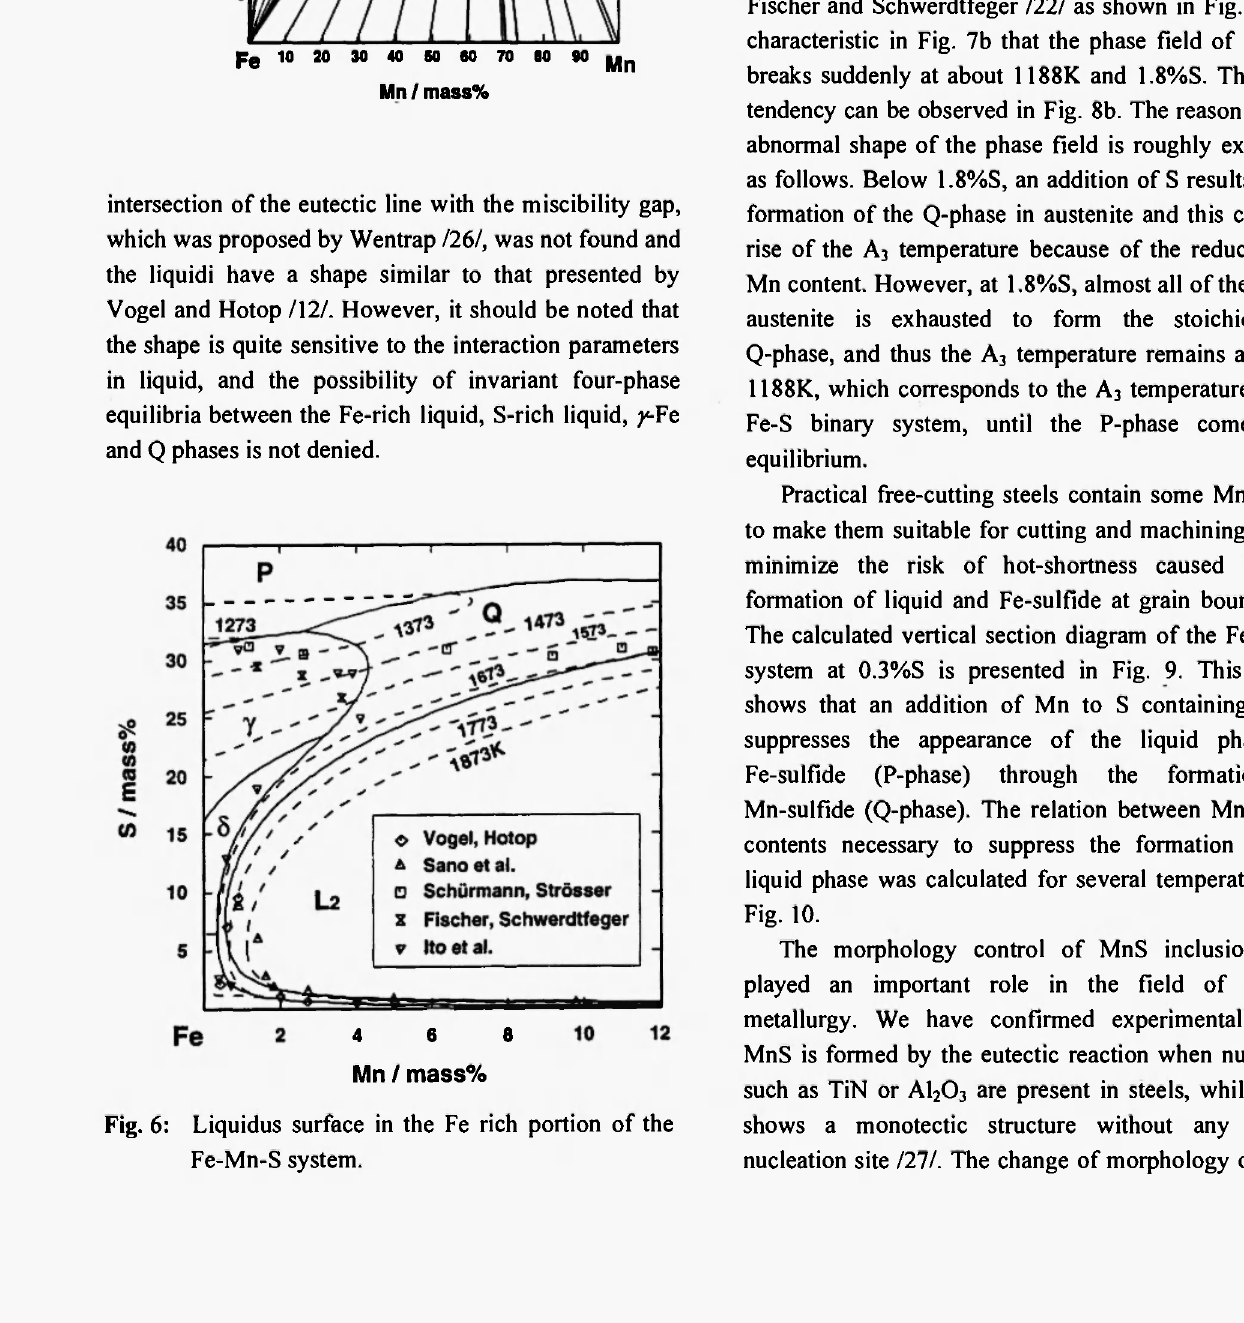
Fig. 6: Liquidus surface in the Fe rich portion of the Fe-Mn-S